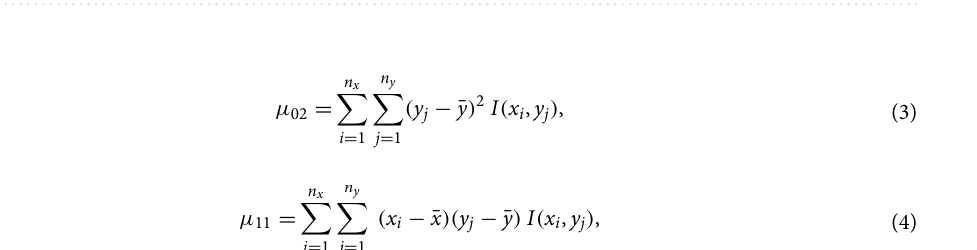
Table 2. The elongation parameter (mean) of F-actin patches, E TIRFM , of 48 melanoma cells, which were at different cell adhesion